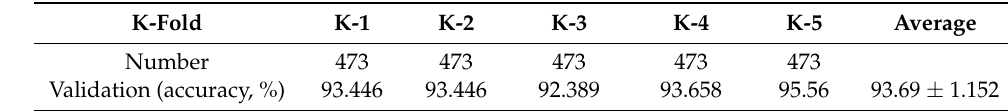
Table 2. Five-fold validation of the accuracy of the current